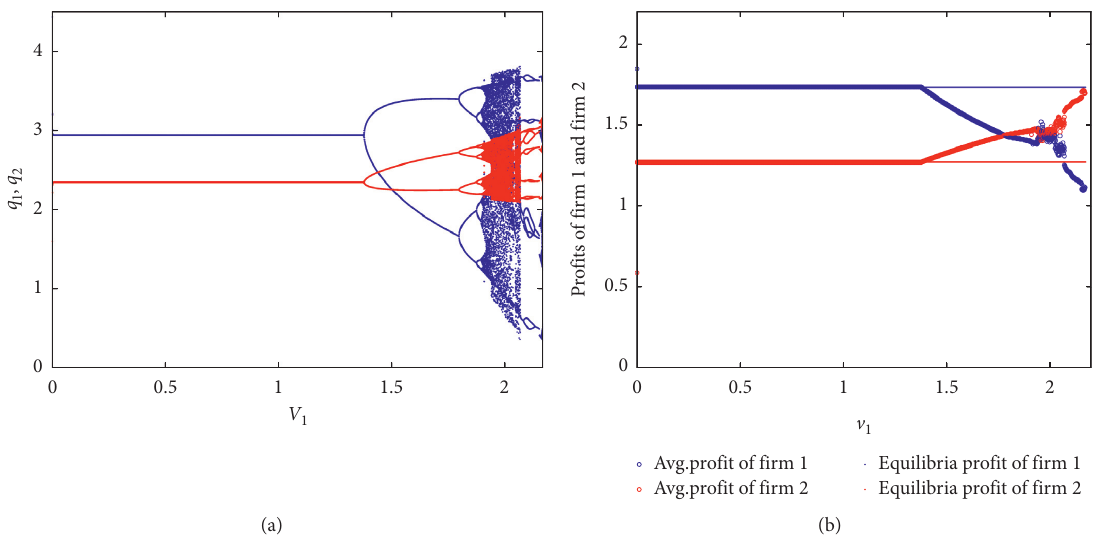
Figure 8: The parameters are chosen as a − c furcation diagram. (b) The profit curves of the two enterprises under the given parameters, where blue represents the profit curve of enterprise 1 and red represents the profit curve of enterprise